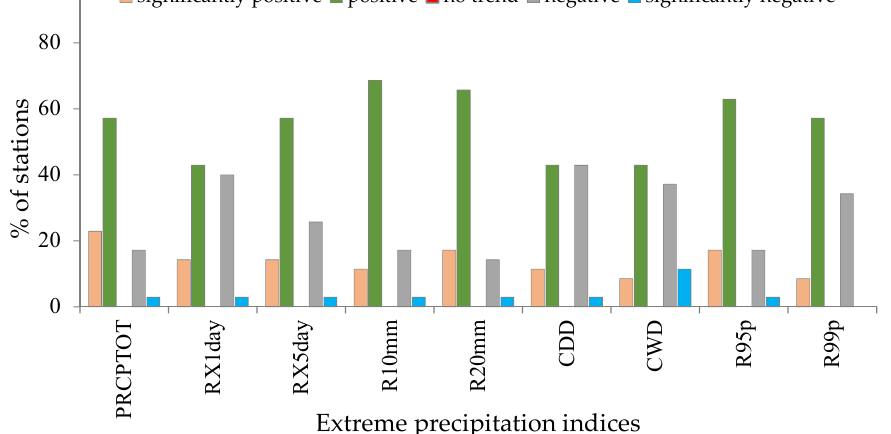
Figure 10. Percentage of all stations with significantly positive, positive, no trend, negative, and significantly negative in extreme precipitation indices.